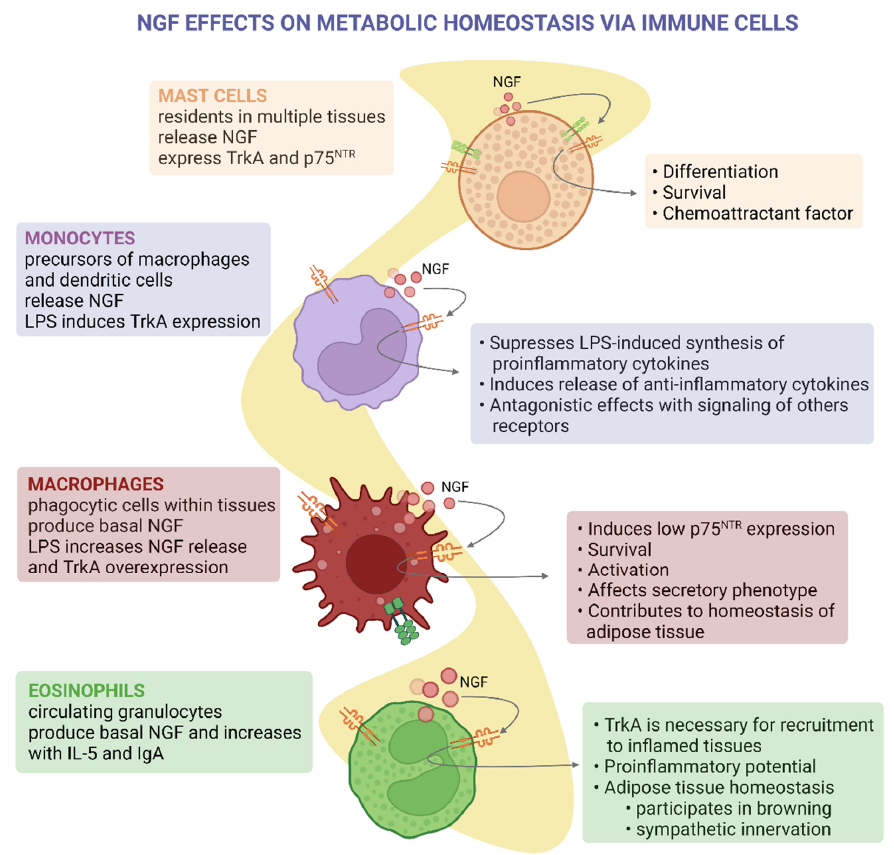
Figure 4. NGF effects on metabolic homeostasis via immune cells. NGF is secreted by different cells of the immune system. Under basal conditions or under different stimuli, these cells express NGF receptors. NGF, through the cells of the immune system residing in the tissues, in addition to regulating the immune response, also exerts actions on cell differentiation and survival and modulates the secretion of cytokines that regulate metabolism in the organs. Created with